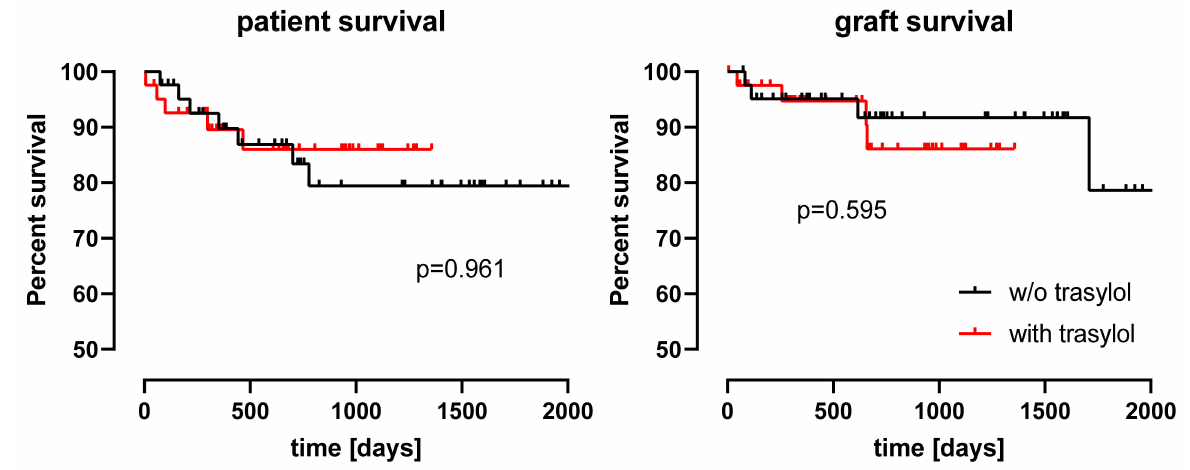
Figure 1. Patient survival and graft survival displayed for treatment with and without (w/o) trasylol. Patient survival ( left ) and graft survival ( right ) did not differ between 42 liver graft recipients receiving aprotinin and 42 matched